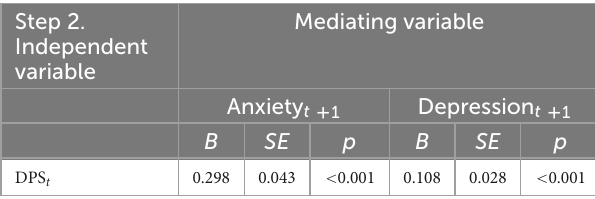
TABLE 5 Step 2 in mediating analysis of DPS t , Anxiety t + 1 , and DPS t + 2 and mediating analysis of DPS t , Depression t + 1 , and DPS t + 2 . Step 2.